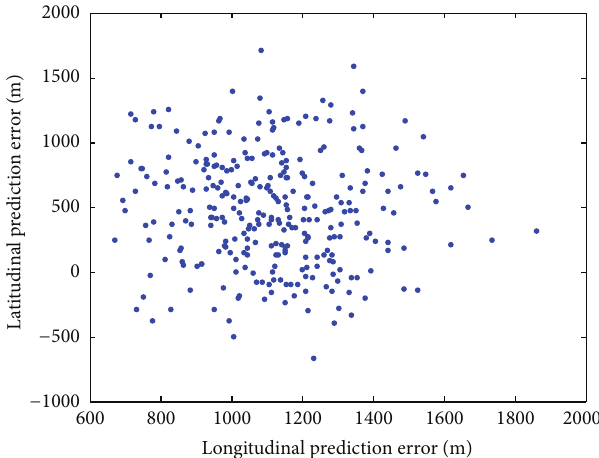
Figure 3: Prediction distributing points of positioning errors.